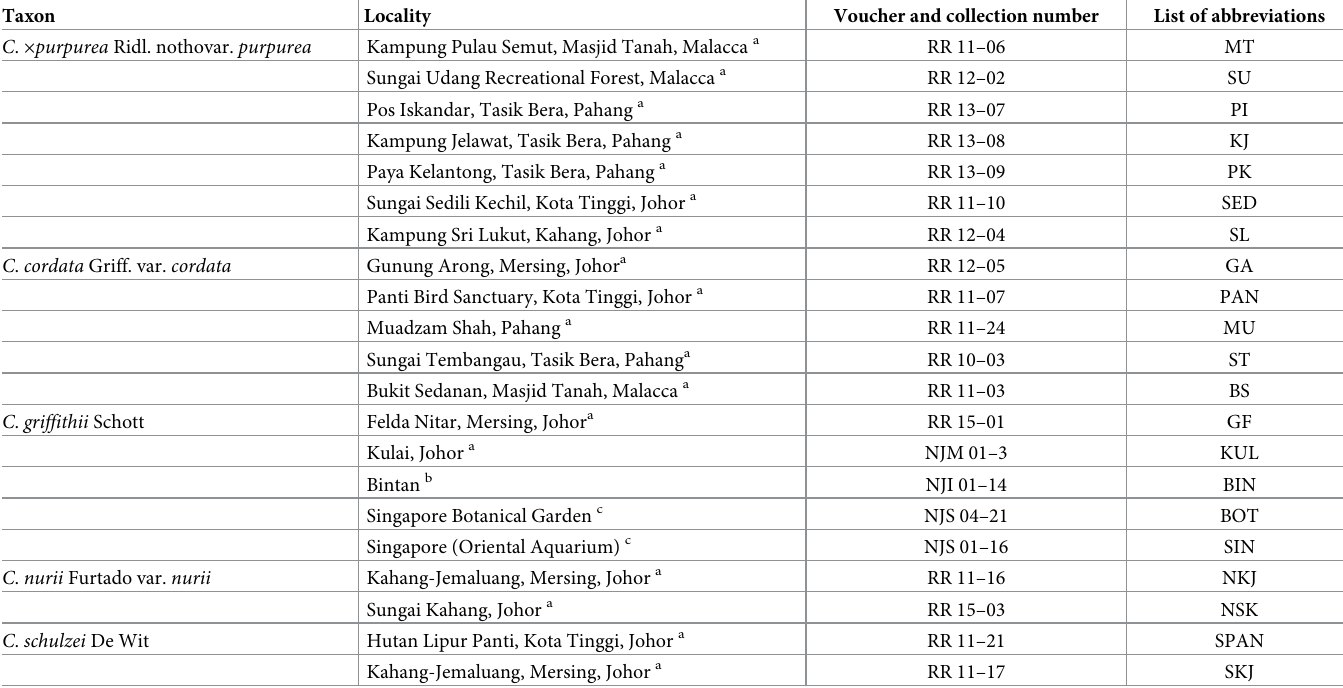
Table 1. Taxa, localities, voucher numbers and list of abbreviations for sampled Cryptocoryne